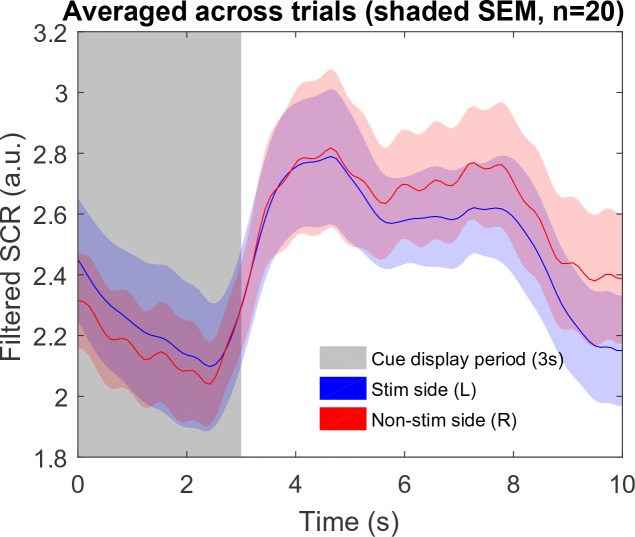
Experiment 2: filtered skin conductance traces (band-pass at 0.0159–2 Hz, 1 st order Butterworth), averaged across all trials within participant (n = 20, excluded participants not shown, shaded region represent SEM across all participants).In Experiment 2, pain ratings took place immediately after cue display period, with variable length of rating time (participant terminates rating whenever they finish). This increased time gap between cue display and outcome account for the second peak in trial averaged SCR trace.